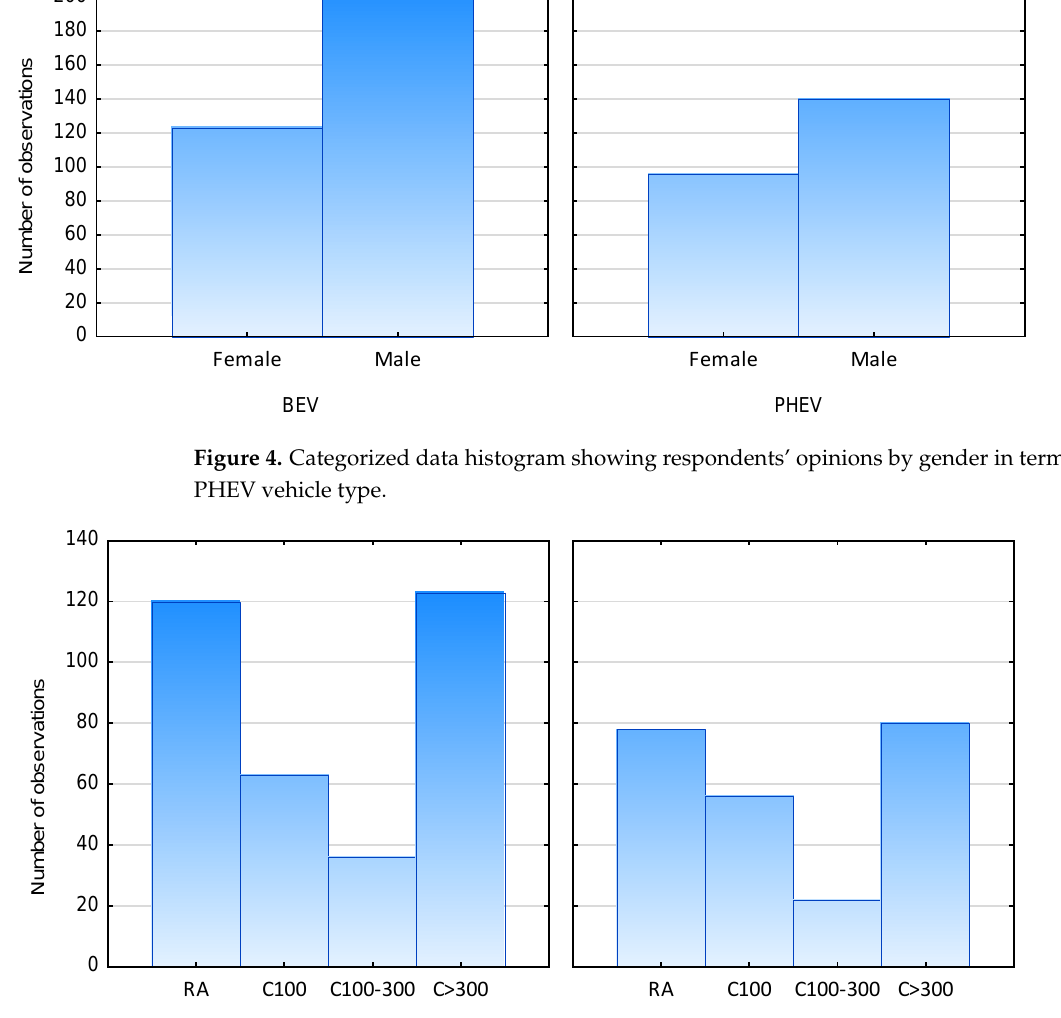
Figure 5. Categorized data histogram showing respondents’ opinions by place of residence in terms of BEV or PHEV vehicle type.